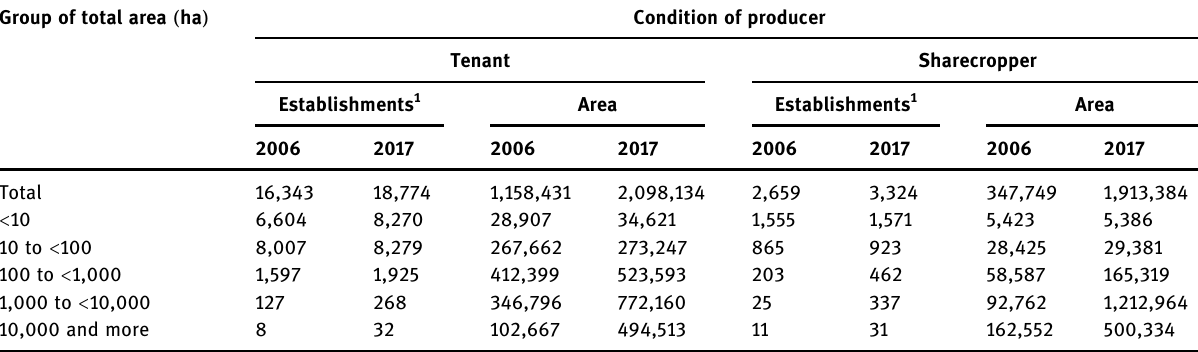
Table 4: Number of establishments and area, according to the producer ’ s pro fi le for the total area of São Paulo ( 2006 and 2017 ) Group of total area ( ha